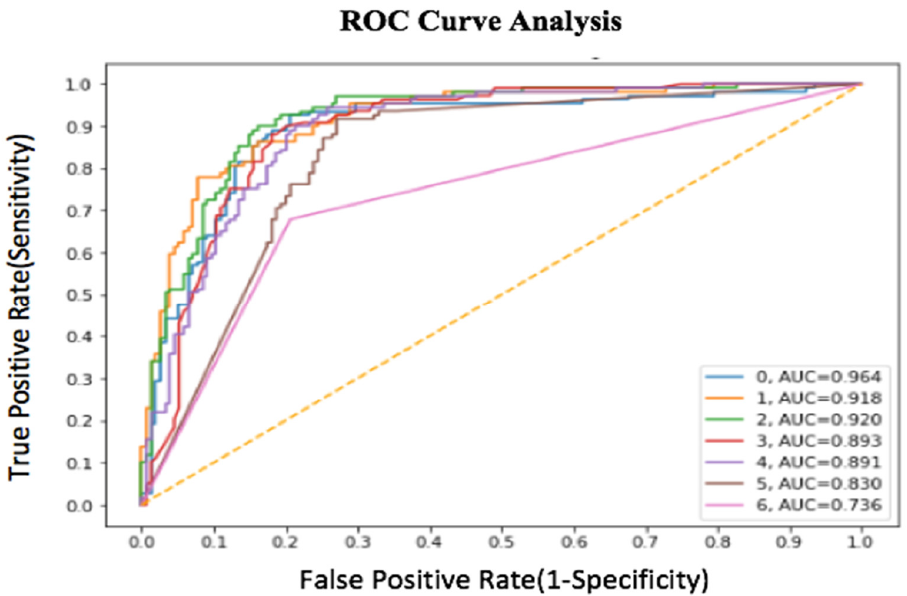
Figure 13. ROC curve analysis of the proposed research.